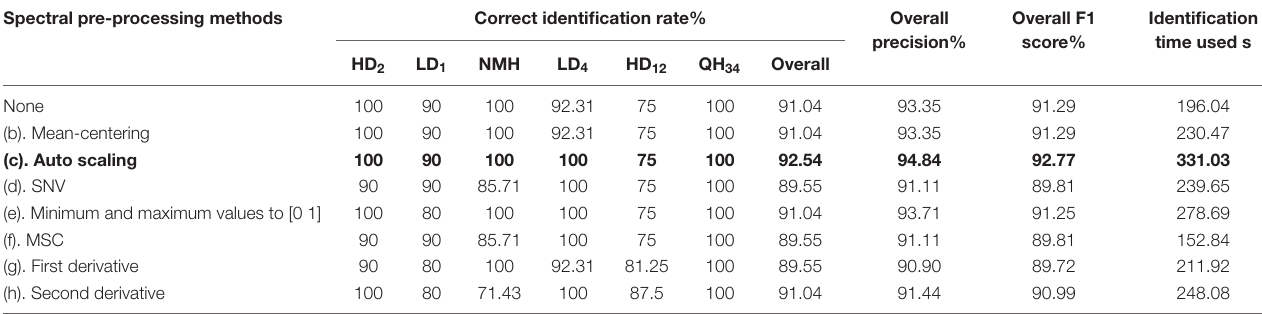
The row with the highest value of overall correct identification rate% and precision% is highlighted in bold. TABLE 3 | GWO-SVM soybean variety identification validation results. Spectral pre-processing